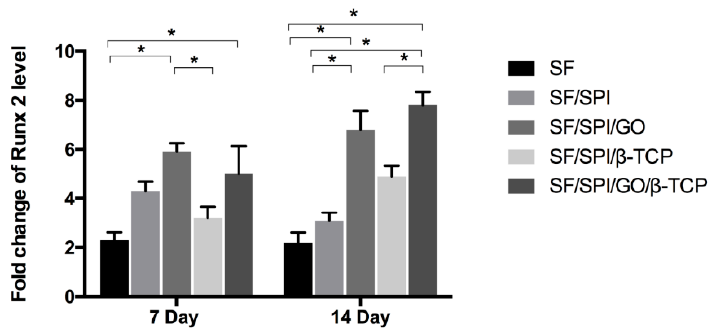
Figure 13. Runx 2 mRNA expression of BMSCs on the SF/SPI-based composite scaffolds on day 7 and 14. Statistical significance relative to each group: * p < 0.05.